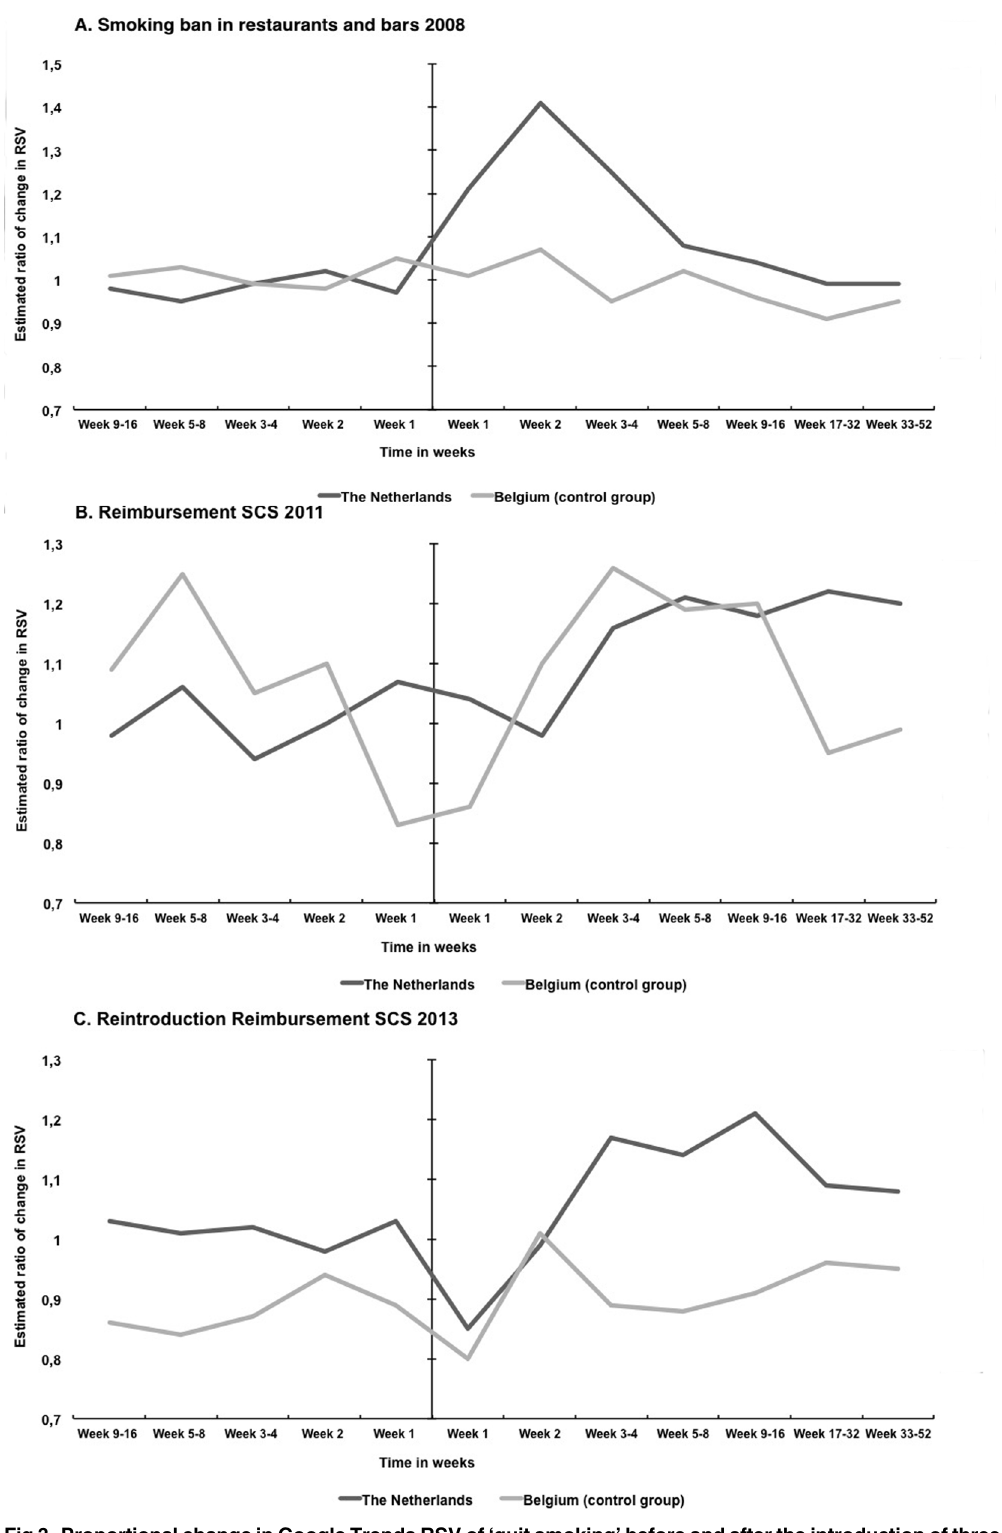
Fig 3. Proportional change in Google Trends RSV of ‘ quit smoking ’ before and after the introduction of three Dutch tobacco control interventions in the Netherlands and Belgium. Interventions are the smoking ban in restaurants and bars of 2008 (A), the reimbursement of SCS in 2011 (B) and the reimbursement of SCS in 2013